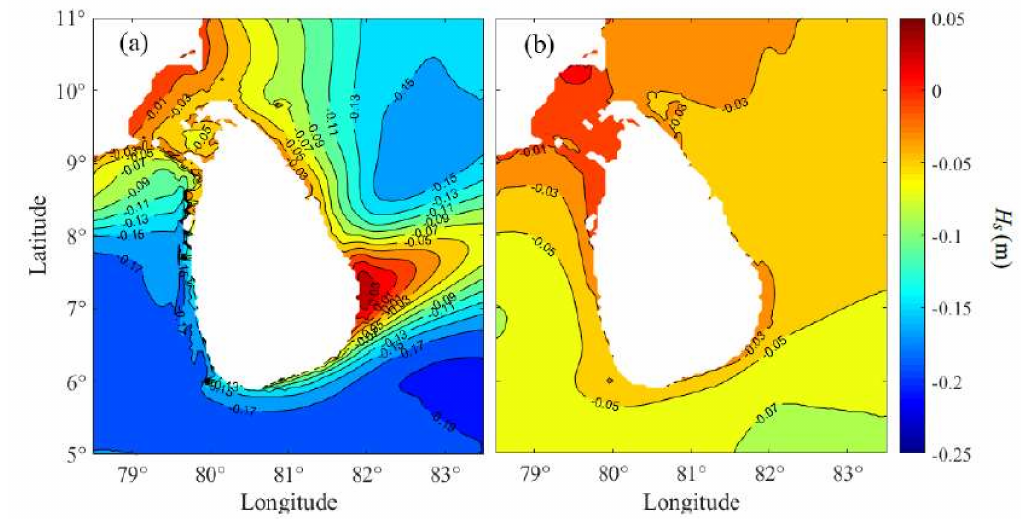
Figure 9. The di ff erence between “future” and “present” average wave height during monsoon and non-monsoon period. ( a ) Monsoon period (May–September); ( b ) Non-monsoon period